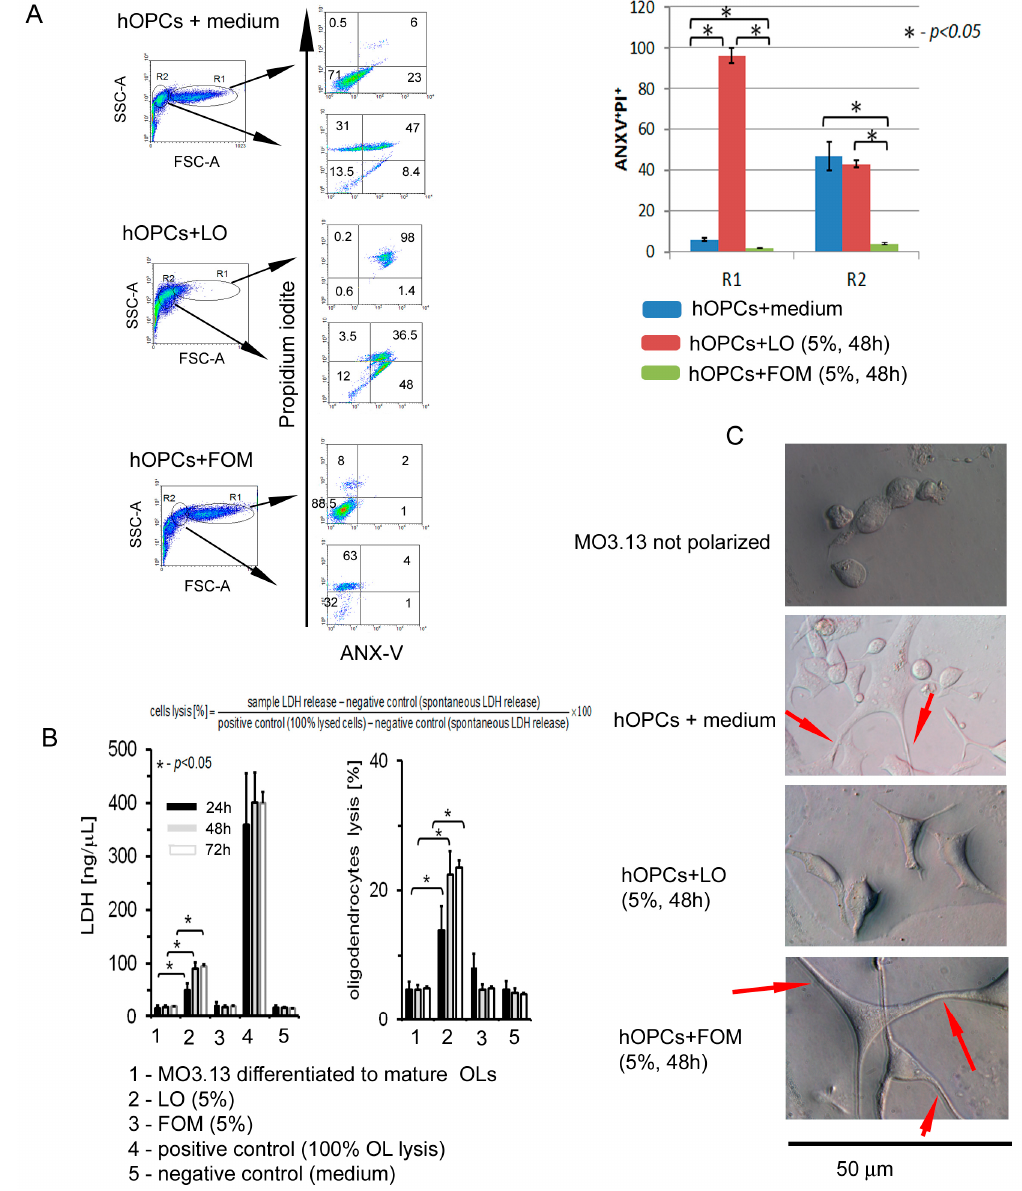
Figure 4. Fish oil mixture prolongates OL lifespan. ( A ) FOM supplementation inhibited spontaneous apoptosis of OLs. Two regions, R1 and R2, were gated based on the morphology (FSC vs. SSC) of MO3.13 cells and analyzed by flow cytometry. The rates of cells undergoing a late phase of apoptosis (double-positivity for propidium iodine and Anexin V) are presented as means ± SD from four independent experiments. ( B ) FOM supplementation had no effect on OL lysis, as LDH concentrations in supernatants were not statistically significant compared to hOPCs cultured alone (left panel). Data (means ± SD from four independent experiments) are presented as LDH concentrations and changes were normalized to positive and negative controls (right panel) according to the formula presented in the upper panel (percentage of lysed oligodendrocytes). ( C ) Differential contrast microscopy (DIC) microscopy analysis presented that FOM, contrary to LO, had no effect on hOPC morphology. Red arrows indicate large lamellipodia and filipodia forming a branched network, confirming the typical structure of OLs in the presence of FOM.